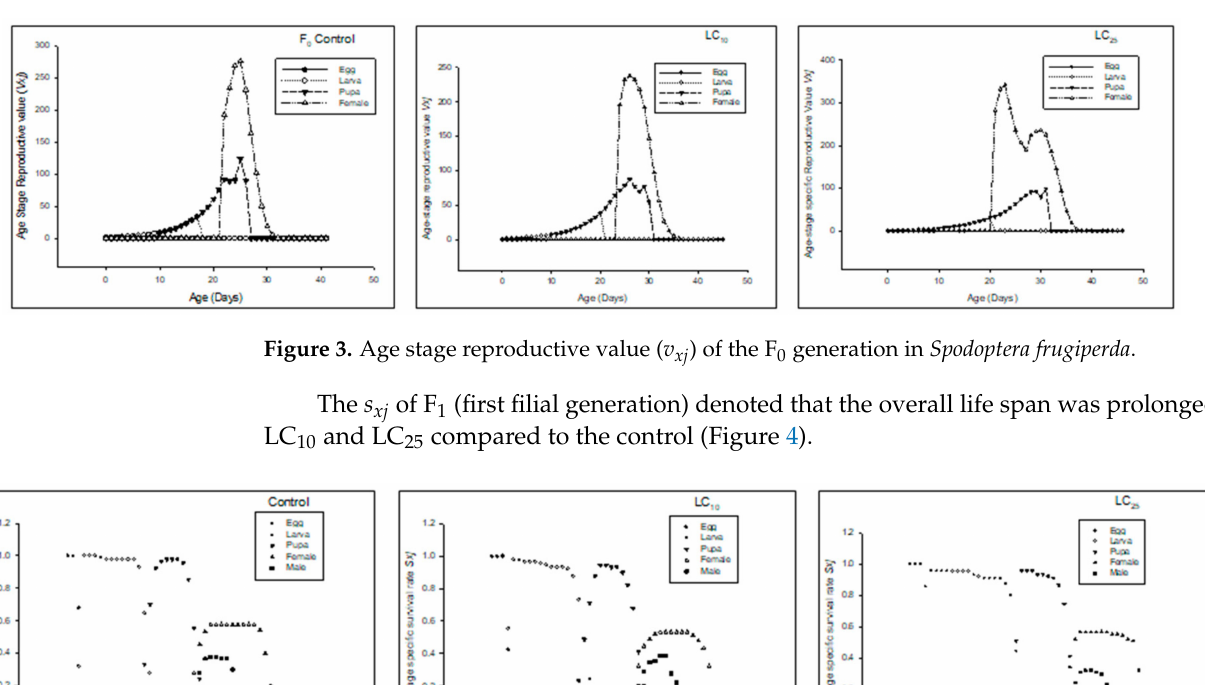
Age-stage specific reproductive rate ( v xj ) of the F 0 generation denoted that the overall reproductive rate reduced in LC 25 -treated insects, and the LC 10 -treated insects also had less reproductive rate as compared to the control (Figure 3).